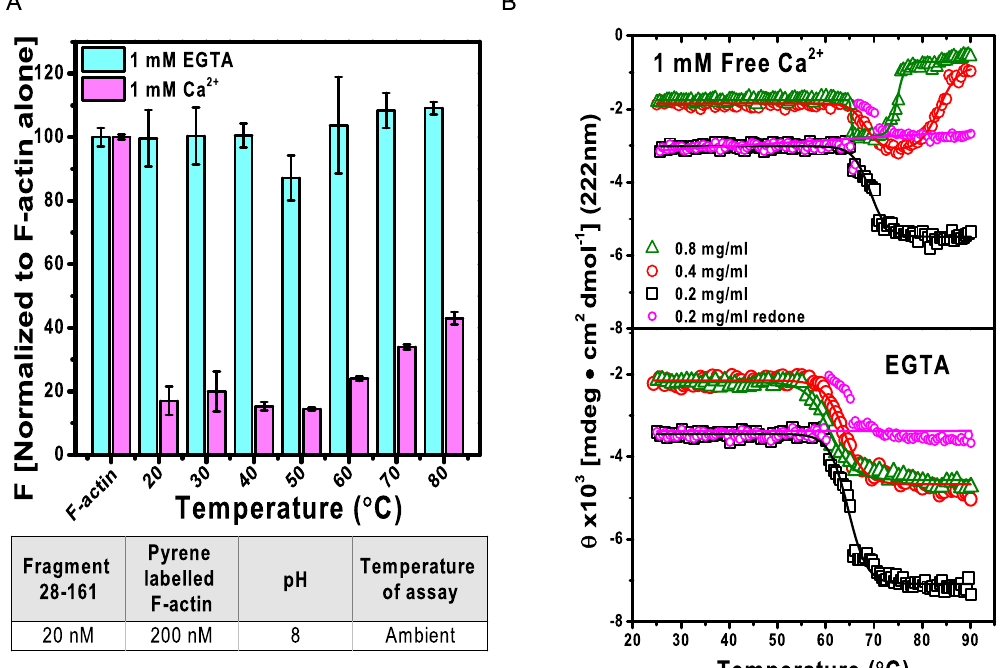
Figure 1. Function-shape of 28–161 as a function of temperature. ( A ) Normalized pyrene fluorescence data indicated that 28–161 protein upon heated till 80 °C followed by cooling and addition of Ca 2 + ions somehow retained or recovered F-actin depolymerizing activity. ( B ) Variation in the MRE values recorded for 28–161 at different concentrations in presence (upper panel) and absence of Ca 2 + ions (lower panel) are plotted here as a function of